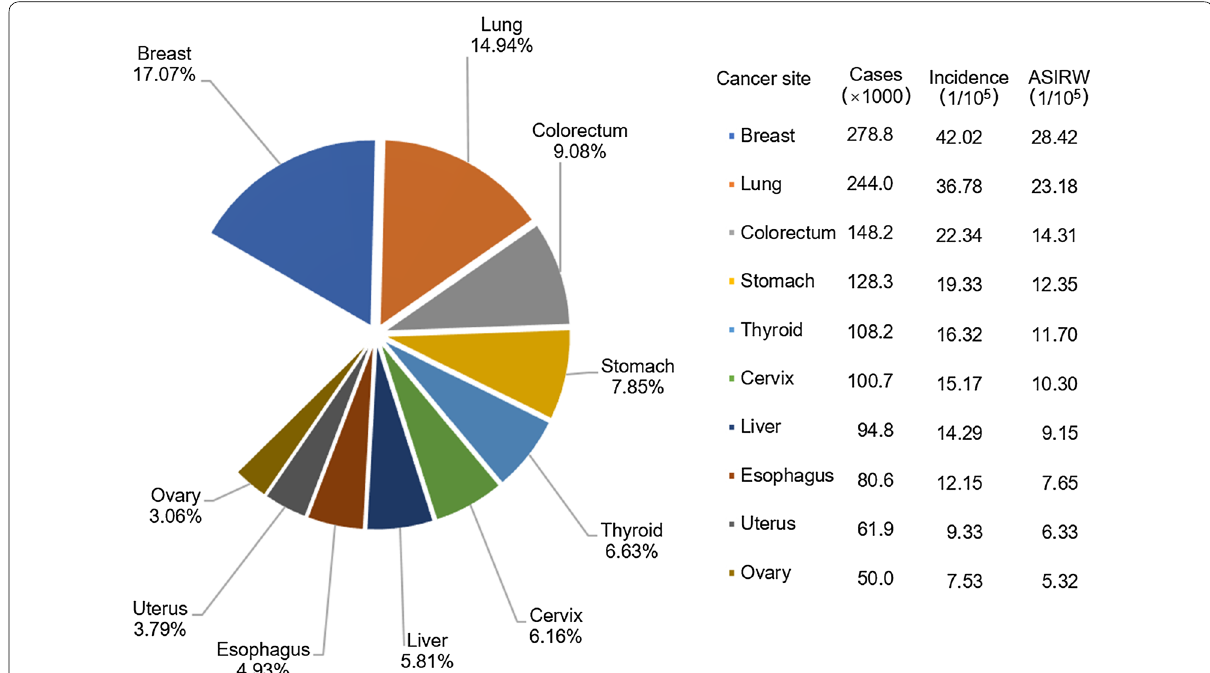
Fig. 3 Incidences of top 10 cancers for females in China, 2013